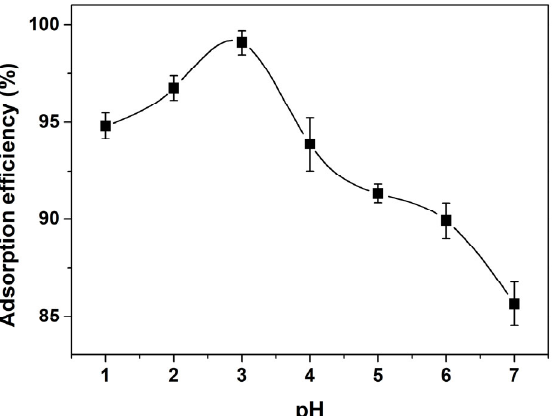
Figure 9. Effect of solution pH on the adsorption efficiency of AO7 onto porous CeO 2 hydrothermally synthesized at 200 °C for 24 h with 4 mmol guanidine carbonate and 4 mL 30% H 2 O 2 ([CeO 2 ] = 2.0 g/L; [AO7] = 180 mg/L; V = 100 mL; t = 60 min; 200 rpm; Room temperature).